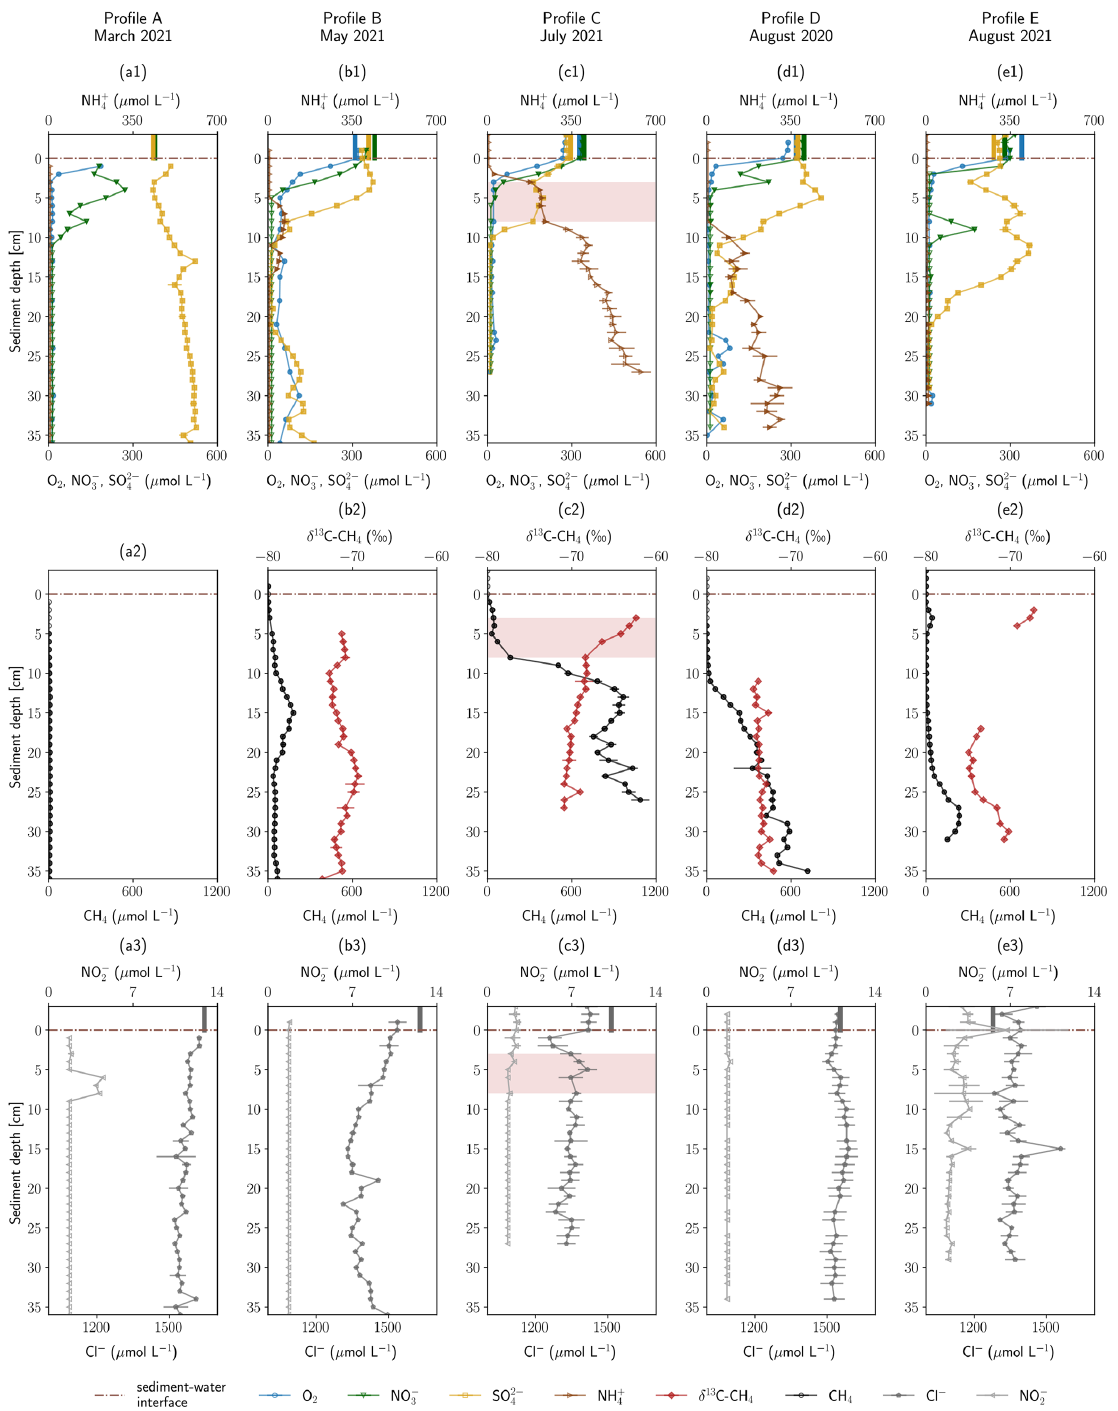
Figure 2. Depth-resolved profiles of hyporheic pore-water geochemistry at five sampling sites. Panels (a1) to (e1) show O 2 , NO − and SO 2 − concentrations. Panels (a2) to (e2) show CH 4 concentrations and δ 13 C–CH 4 values. Panels (a3) to (e3) show NO − 4 concentrations. Empty markers indicate values outside the range of used standards. Error bars show standard deviations of independent measurements ( n = 3). Vertical lines above the sediment–water interface are concentrations measured in the surface water at the sampling date. Red background color highlights an enrichment in δ 13 C–CH 4 . Profiles are ordered by